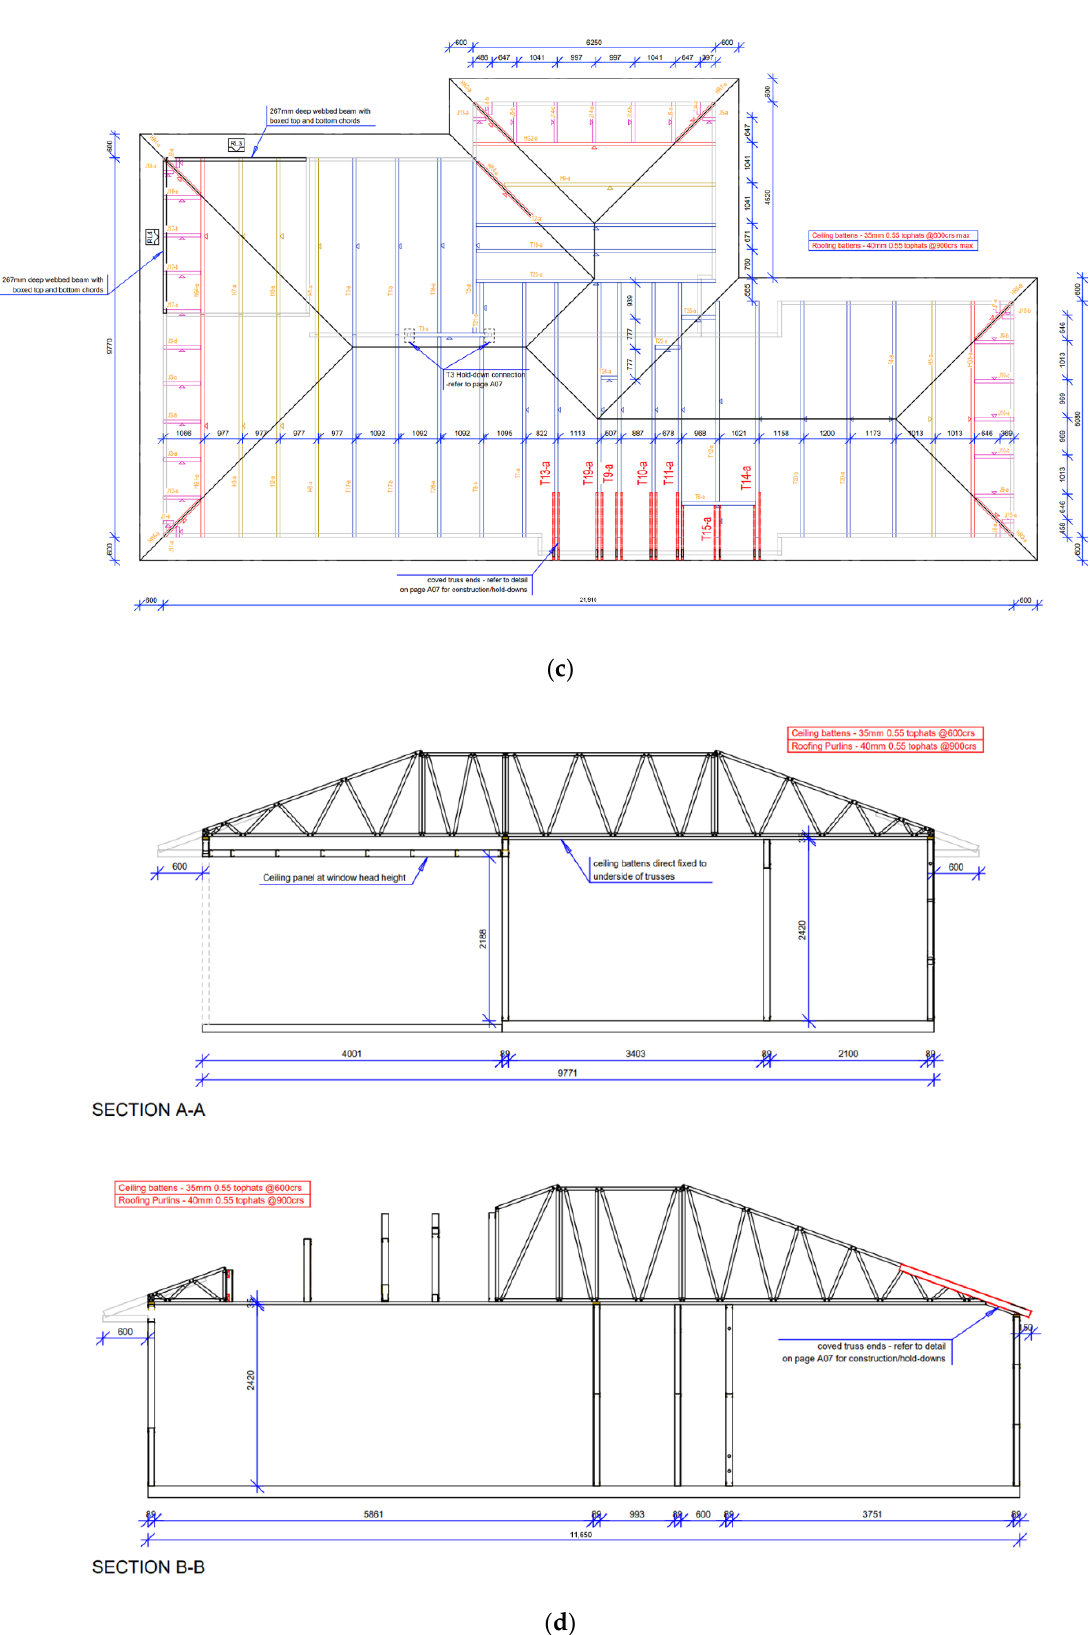
Figure 3. ( a ) Framing outline; ( b ) wall layout; ( c ) roof layout; and ( d ) sectional plans of the analyzed house (all measurements are in millimeters).